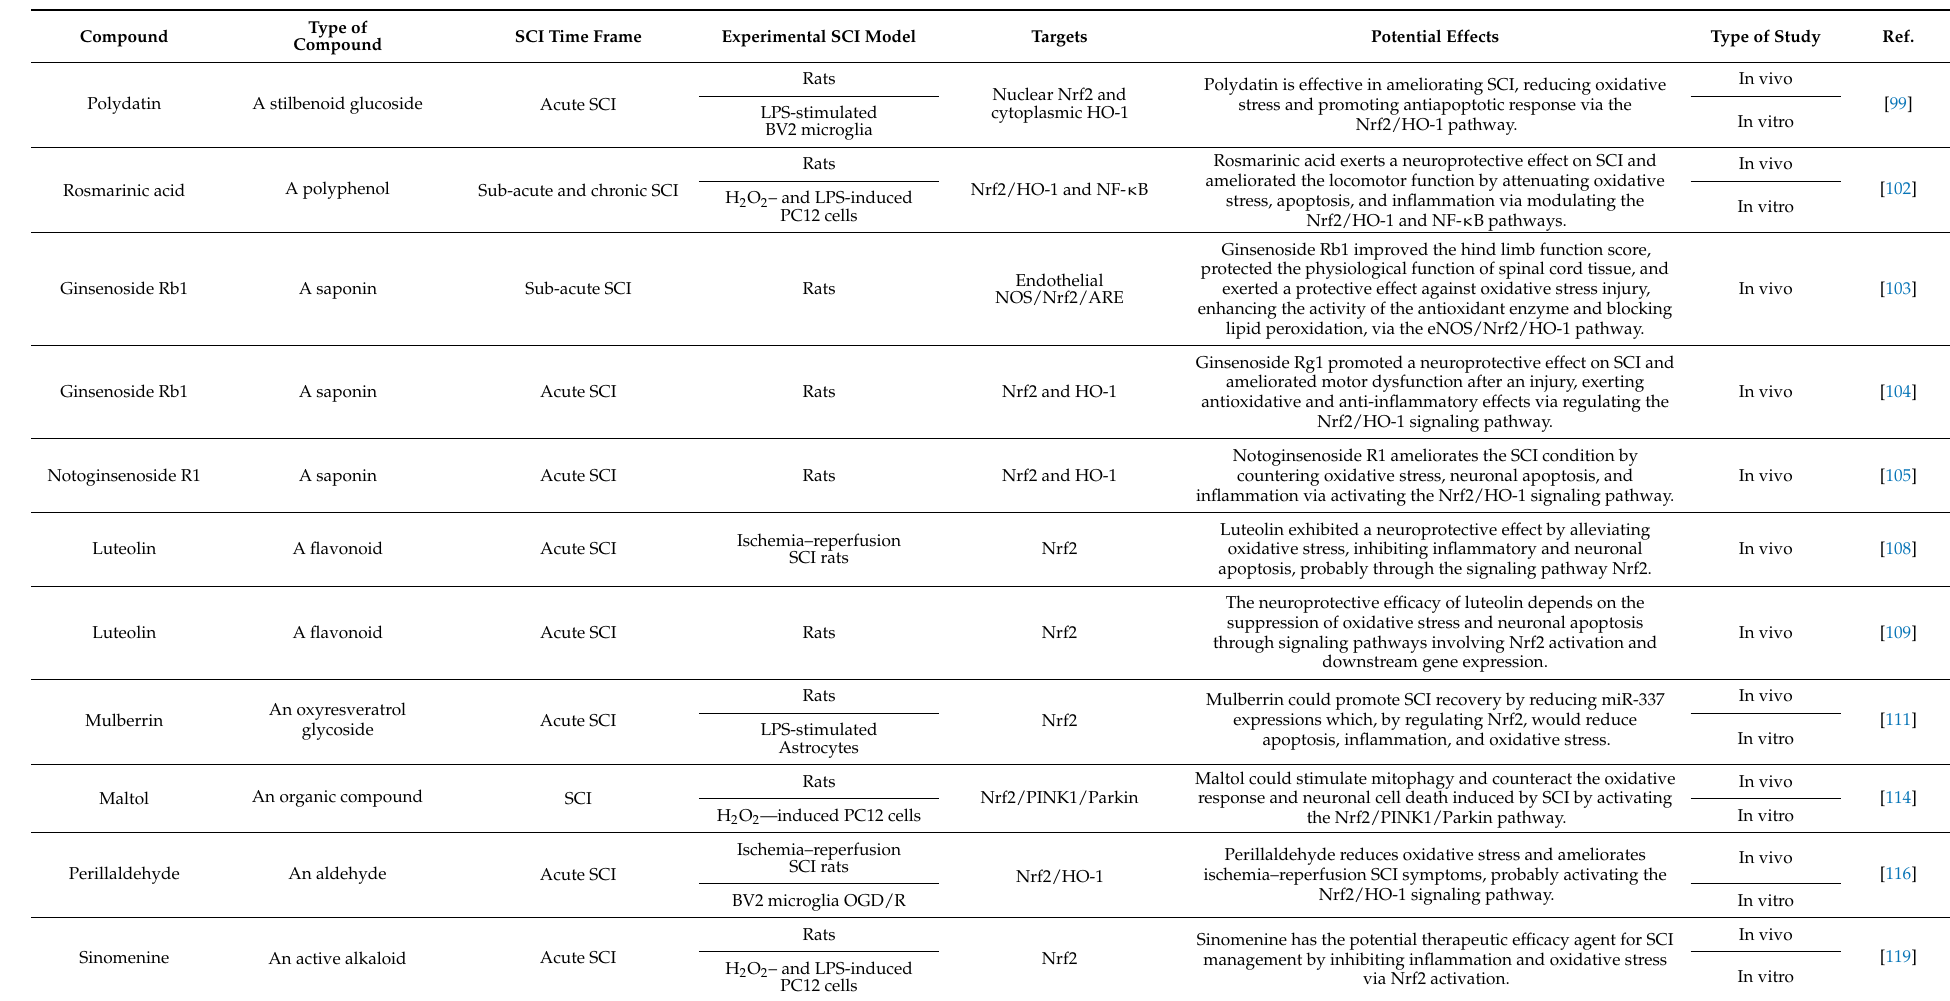
Table 1. Potential natural compounds Nrf2 activators for controlling SCI symptoms and improving functional